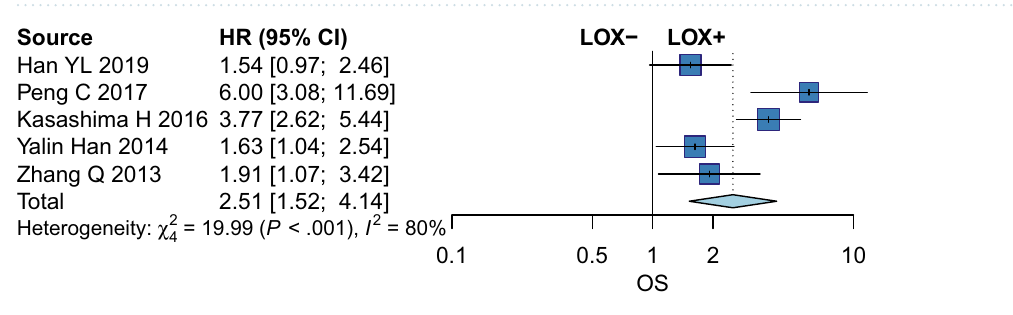
Figure 4. Forest plot for the association of LOX expression with